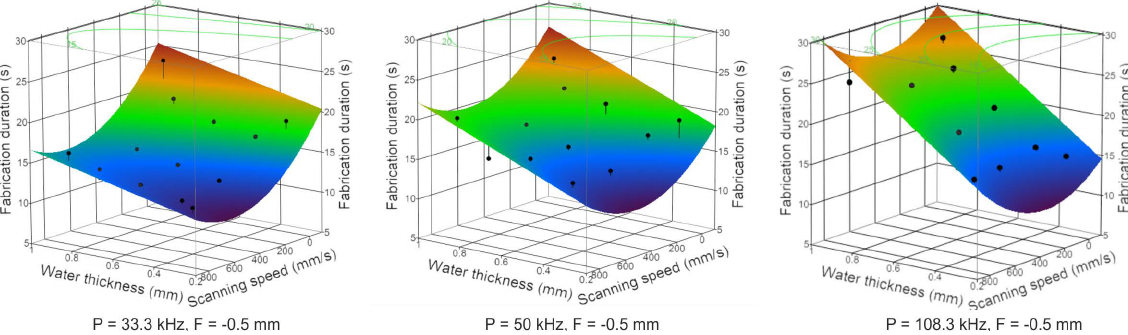
Figure 5. Water thickness and scanning speed values vs. results (fabrication duration for cutting glass) graphs at different repetition rates and fixed focal position settings. The black dots are the actually measured points; the surface is produced via the prediction